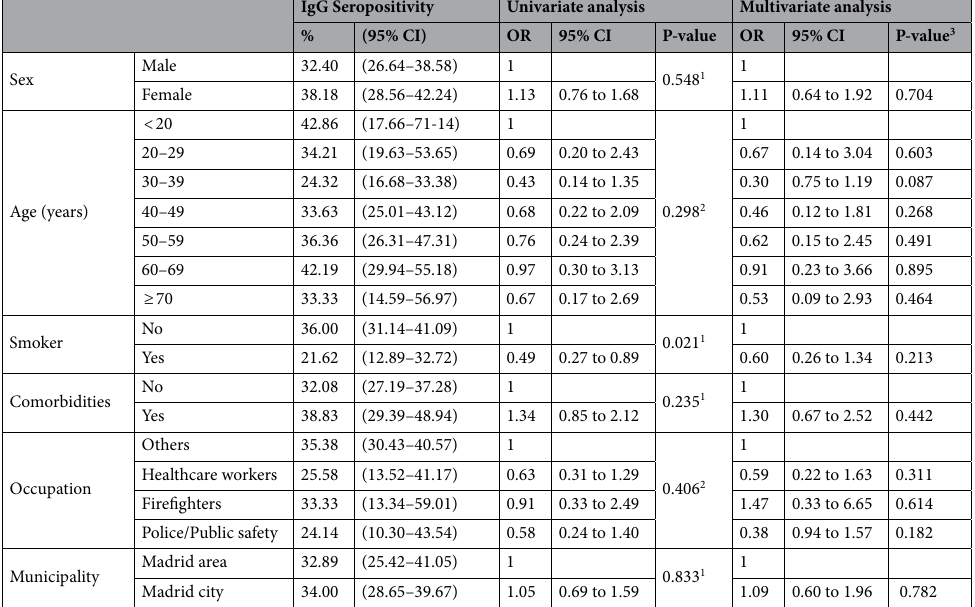
Table 2. SARS-CoV-2 IgG seropositivity by general characteristics. 1 Fisher’s exact test. 2 Chi-square test. 3 Enter multivariate logistic regression. OR: Odds Ratio. 95% CI: 95% Confidence Interval.